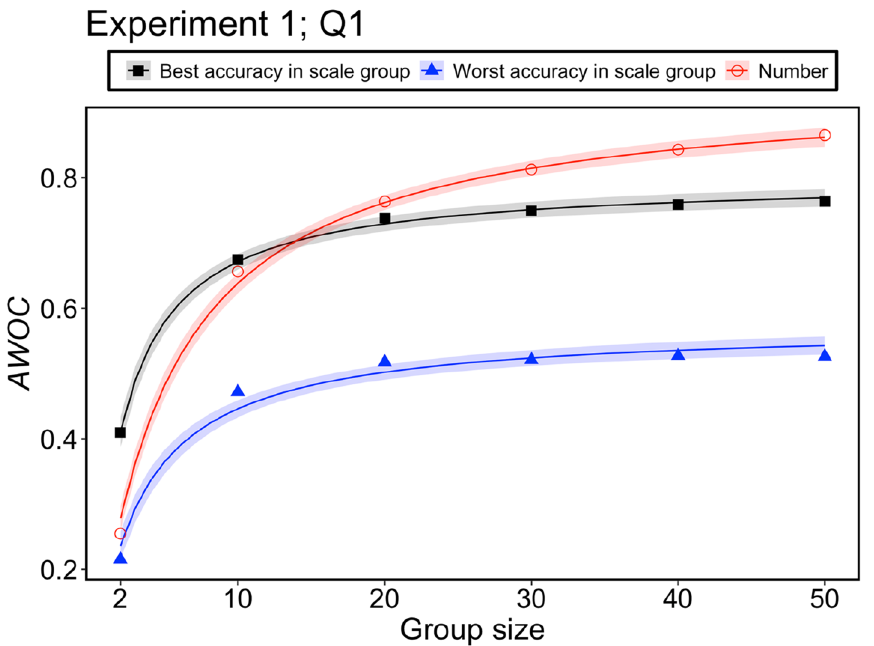
Figure 11. Comparison of AWOC between the three groups (the number group and the best and worst accuracy scale groups) in Question 1 of Experiment 1. The point demonstrates the group performance calculated by the computer simulation. The line shows the prediction by the Eq. (3). This prediction was based on the estimated parameters (median of posterior distributions) by the hierarchical Bayesian method. The shadow area indicates a 95% Bayesian credible interval based on estimated parameters in Eq.